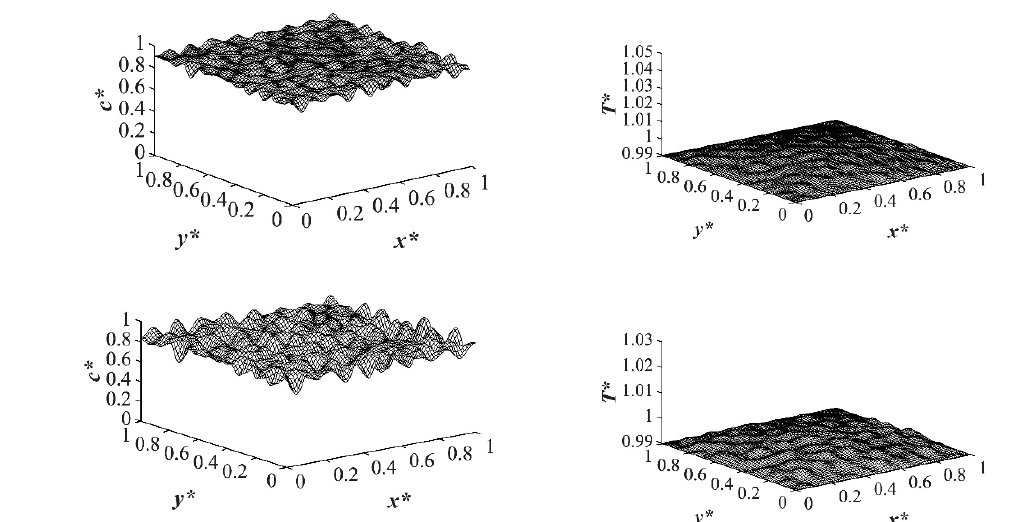
Figure 13. The influence of initial solution temperature on phase separation through TIPS process with two different dimensionless initial solution temperatures of ( a ) T * = 1.05 and ( b ) T * = 1.03 to the same quench temperature of T * q2 = 0.99 at time t * = 5.03 × 10 − 4 .